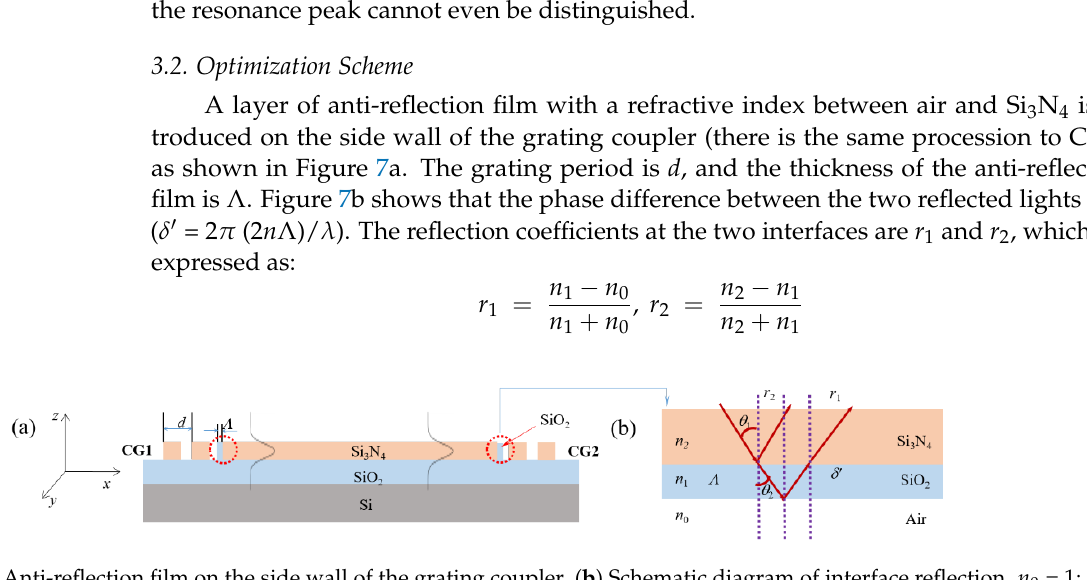
Figure 7 . ( a ) Anti-reflection film on the side wall of the grating coupler. ( b ) Schematic diagram of interface reflection. n 0 = 1; n 1 = 1.45; n 2 = 2.4.